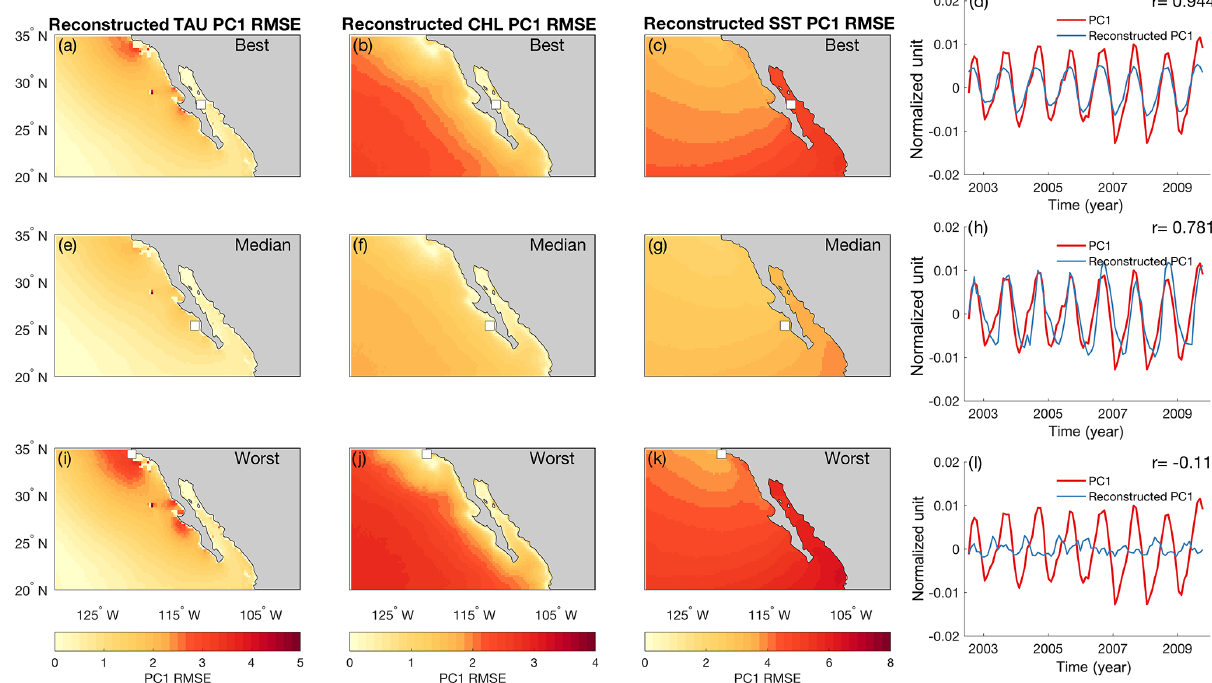
Figure 8. (a–d) Best, (e–h) median, and (i–l) worst PC1 reconstruction spatial RMSE and time series using only one variable from one site. The white marker indicates the site used in that reconstruction, with the circle indicating SST and the square indicating CHL. The means of both time series were removed for visualization